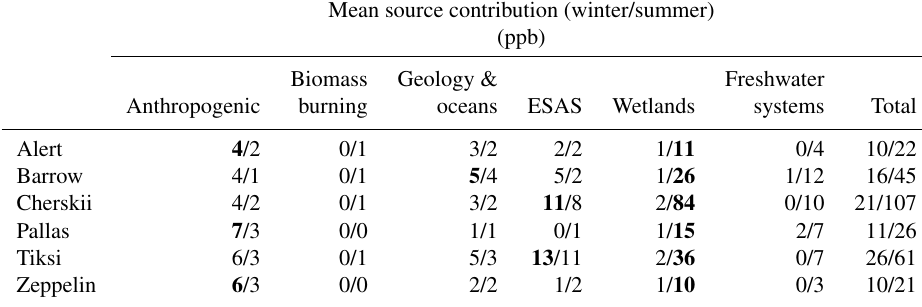
Table 4. Same as Table 3, but for the absolute values, in